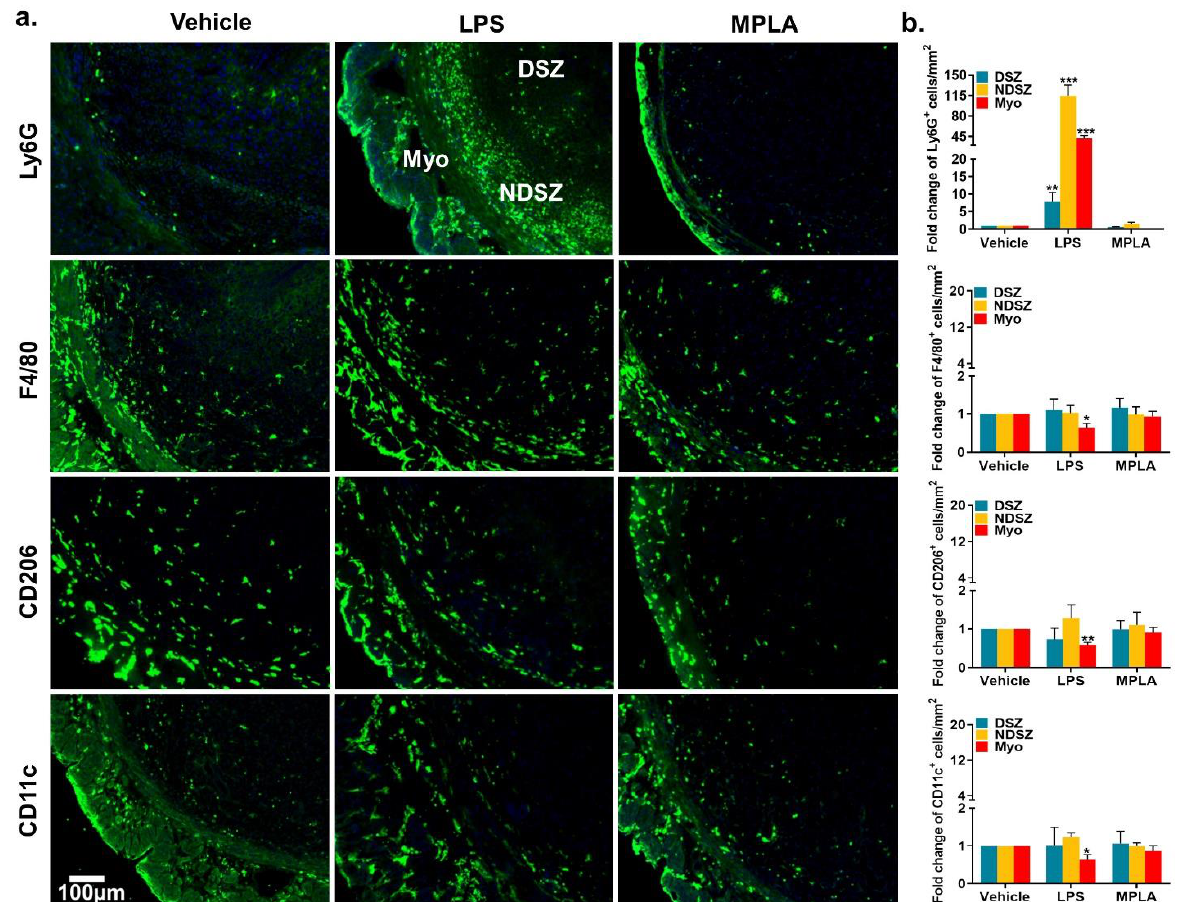
Figure 8. Maternal LPS exposure triggered only neutrophil infiltration at the EBIS. Vehicle (saline), MPLA and LPS (1µg/mouse) were intraperitoneally injected on day 5 of pregnancy and neutrophils, macrophages and dendritic cells were identified at the EBIS 24 h later. ( a ) Representative immunofluorescence images of EBISs from vehicle, LPS and MPLA treatment groups. Here neutrophils were stained with Ly6G antibody, macrophages were identified using F4/80 and CD206 antibodies, DCs were stained with CD11c antibody. Cross sections obtained from two pieces of uterine tissues/mouse/dose of day 6 of EBIS were fixed, immunostained with respective primary antibodies, counterstained with DAPI (blue) and photographed. At least six pregnant mice were used for each treatment. DSZ, decidualized stromal zone; Myo, myometrium; NDSZ, non-decidualized stromal zone; ( b ) Quantification of immune cells at the EBIS following vehicle, LPS and MPLA treatment. Total number of Ly6G + , F4/80 + , CD206 + and CD11c + cells were counted in three distinct regions (DSZ, NDSZ and Myo) of the EBIS. At least three immunostained sections from each treatment group were used for immune cell counting. Results are shown as the fold change relative to vehicle control and represent the mean ± SD. * p < 0.05, ** p < 0.01, *** p < 0.001 (ANOVA followed by Tukey test).